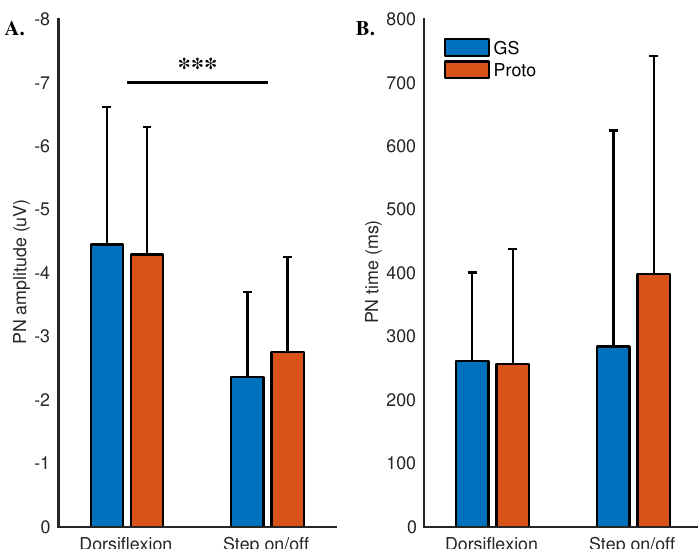
Figure 4. Means and standard deviations for ( A ) the peak negative value and ( B ) its time for the two systems across the tasks. ‘***’ represents p -value less than 0.001.